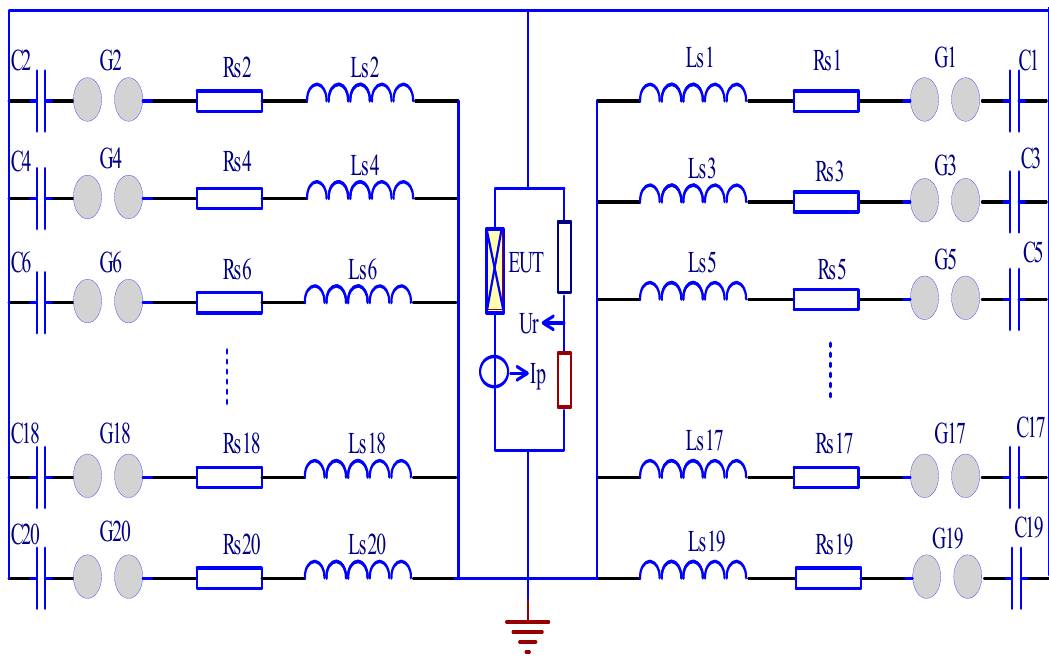
Figure 2. Multiple lightning impulse current generator circuit diagram.